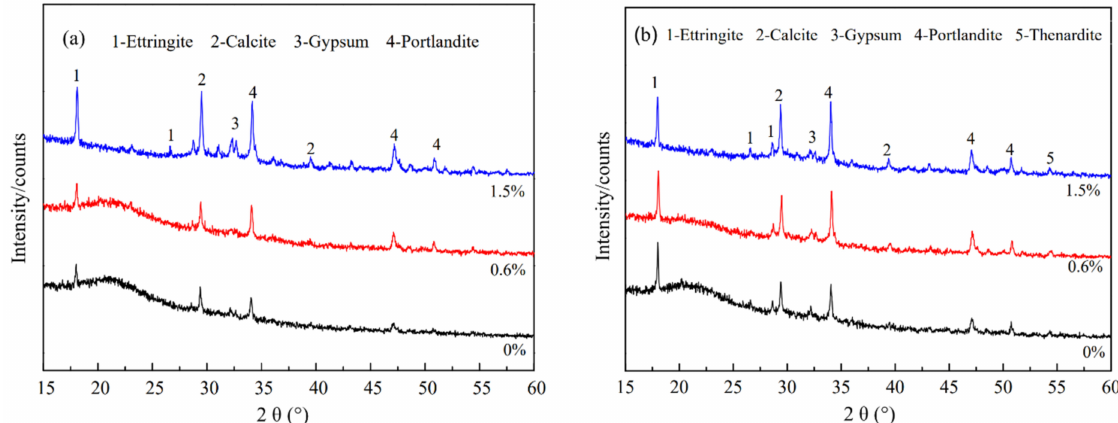
Figure 12. XRD diagram of the hydration product from the same age of the specimen after standard curing and 150 sulfate dry-wet cycles: ( a ) standard curing; ( b ) 150 sulfate dry-wet